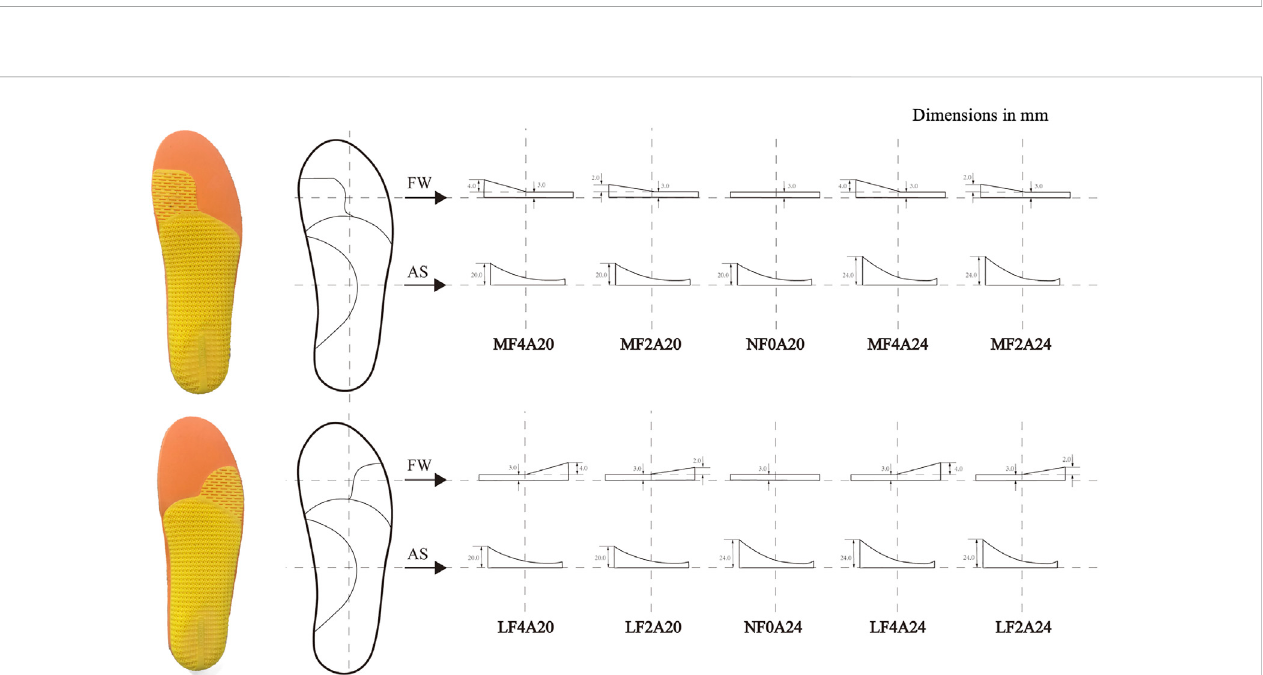
FIGURE 2 Bottom view and dimensions of ten FOs with abbreviations. FW: forefoot wedge, AS: arch support. MF4, MF2, NF0, LF2, LF4 stand for a forefoot wedge with 4 mm medial, 2 mm medial, 0 mm, 2 mm lateral, and 4 mm lateral wedge, respectively; A20 and A24 stand for an arch support with a height of 20 mm and24 mm,respectively.Thebaselayerinyellowwascomposedofaconventionalthree-quarterorthosiswithorwithoutaforefootwedge.Footorthosiswas composed of a 3D printed base layer and fl at full-length top